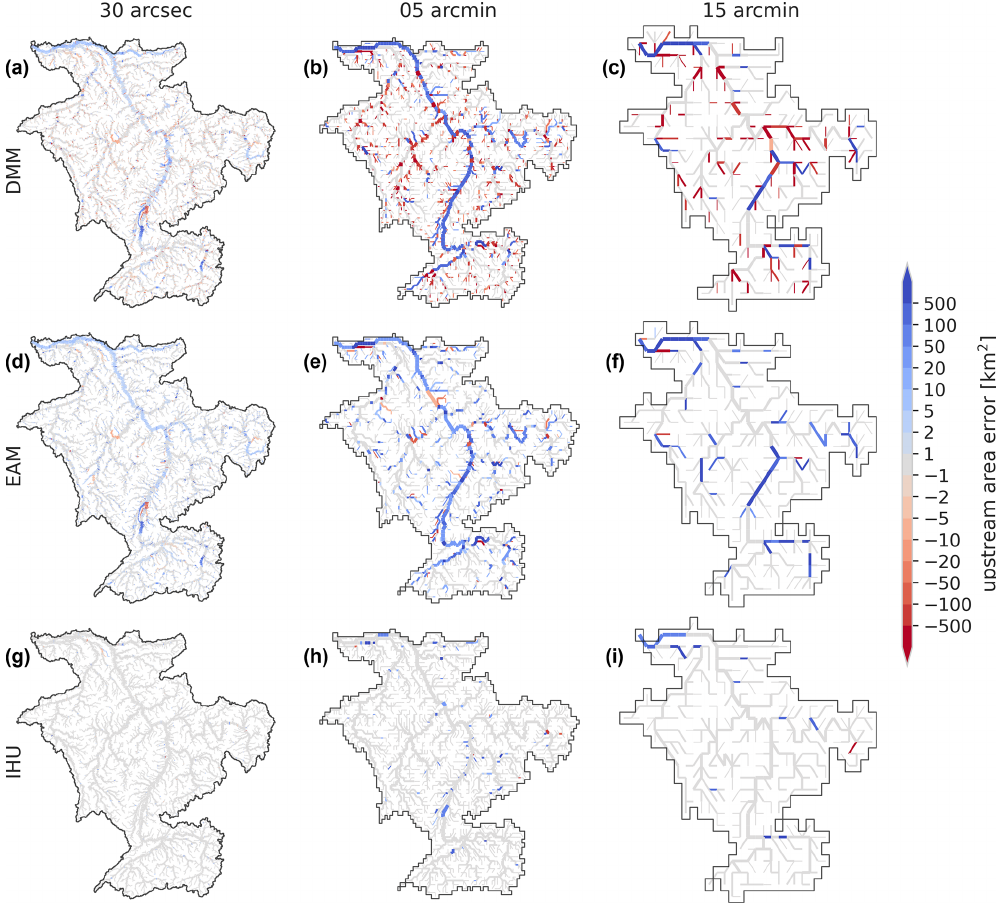
Figure 6. Upscaled MERIT Hydro flow direction network for the Rhine at resolutions of 30arcsec (a, d, g) , 5arcmin (b, e, h) and 15arcmin (c, f, i) as derived with the DMM (a–c) , the EAM (d–f) and IHU (g–i) , where red colors indicate a negative and blue colors a positive upstream error. The line thickness is scaled with the upstream area.